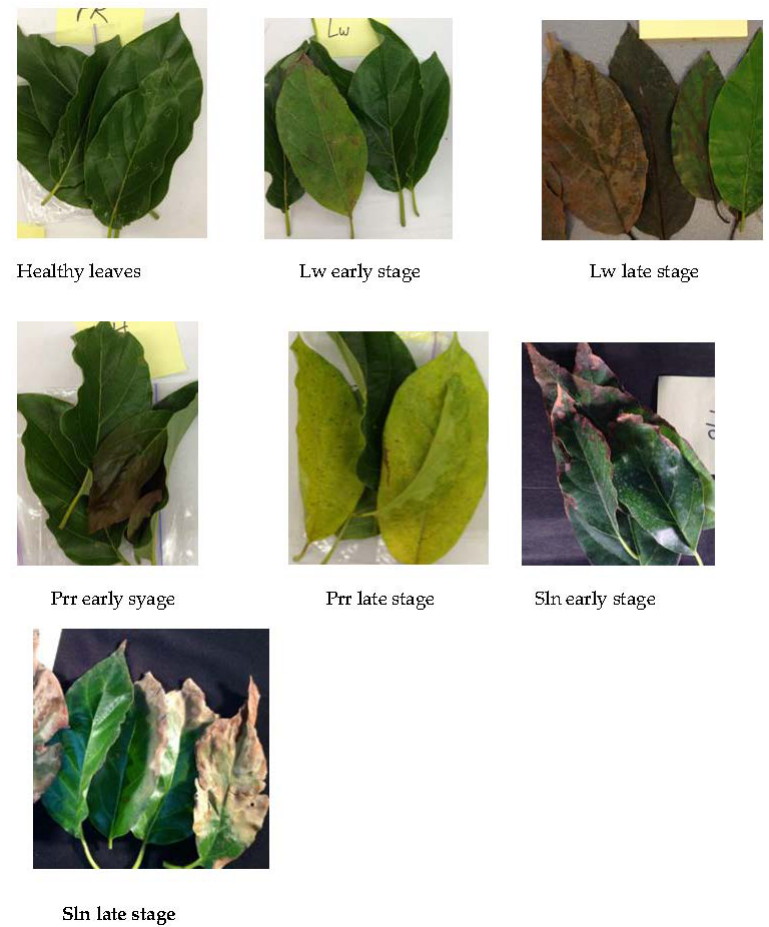
Figure 1. Avocado leaves in different stress stages: healthy, laurel wilt (Lw), Phytophthora root rot (Prr), and Salinity (Sln).